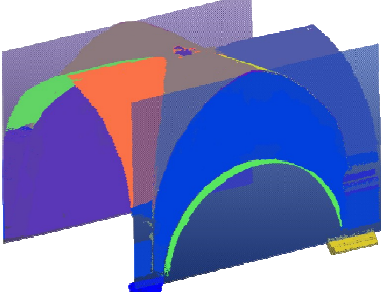
Figure 9 Application of the RANSAC to the dense point cloud.